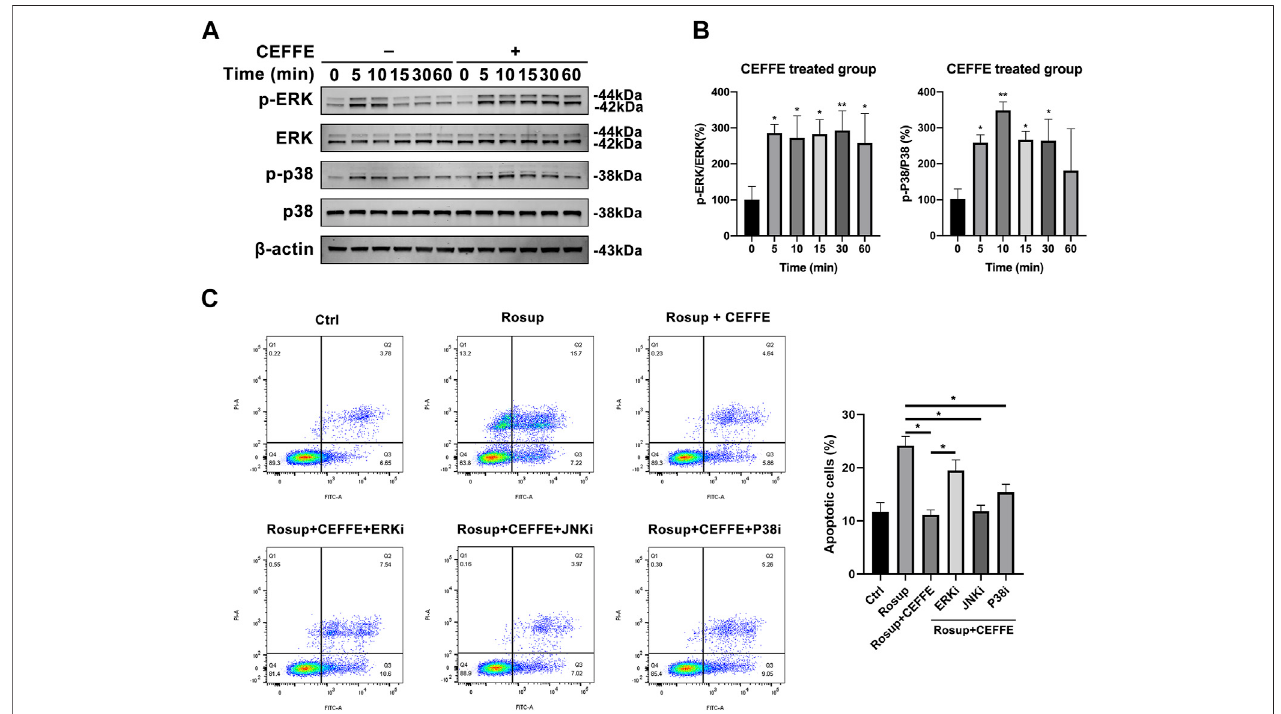
FIGURE6| CEFFEinhibitedosteocyteapoptosisthroughERKandp38signalingpathway. Cellswereincubated withCEFFE(250 μ g/ml)fortheindicatedperiods, andproteinswerecollectedwithin1 htoassessactivationofMAPKsignalingpathways,includingERKandp38 (A,B) .Incubationwithsmall-moleculeinhibitorsofMAPK signaling pathways signi fi cantly counteracted anti-apoptosis induced by CEFFE (C) . * p < 0.05, ** p < 0.01 vs.